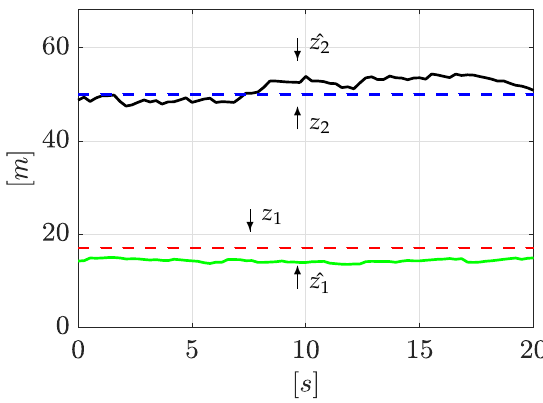
Figure 6. Estimation of leak positions.